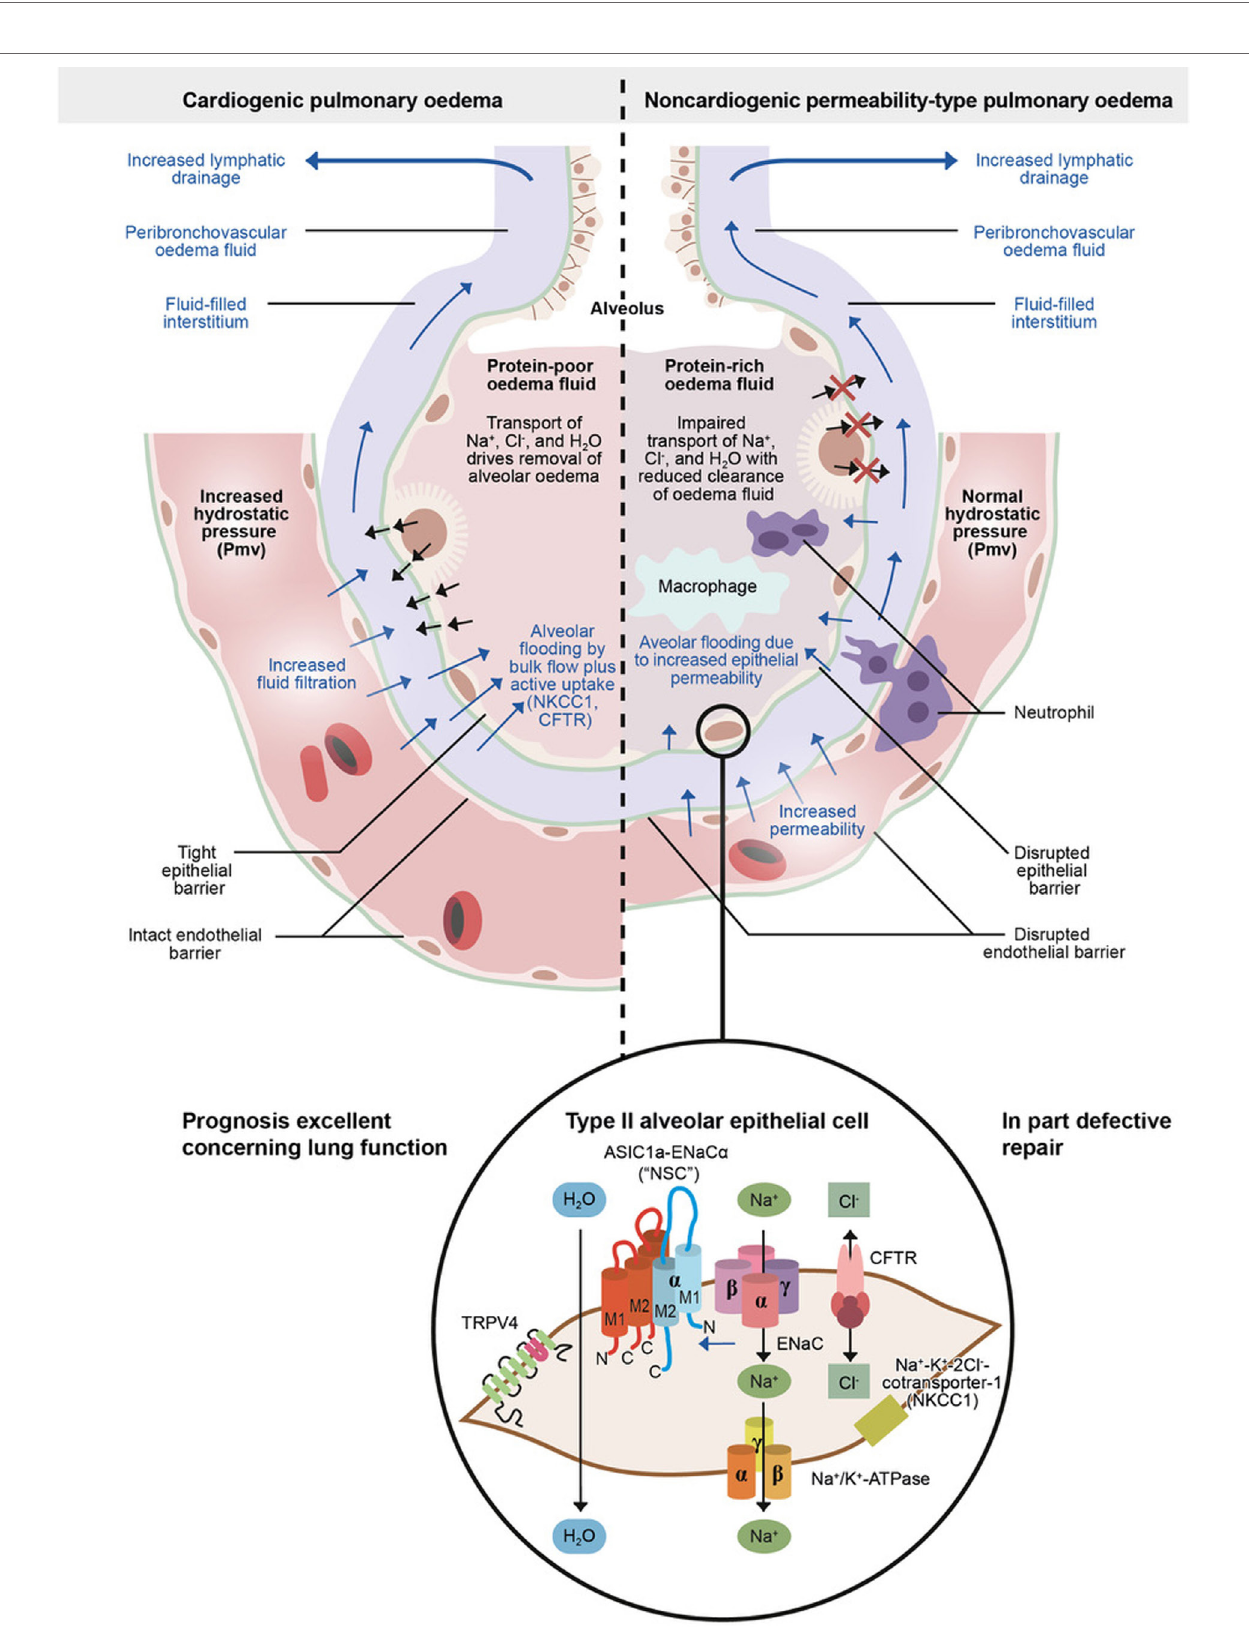
FigURe 2 | Physiology of microvascular fluid exchange in the